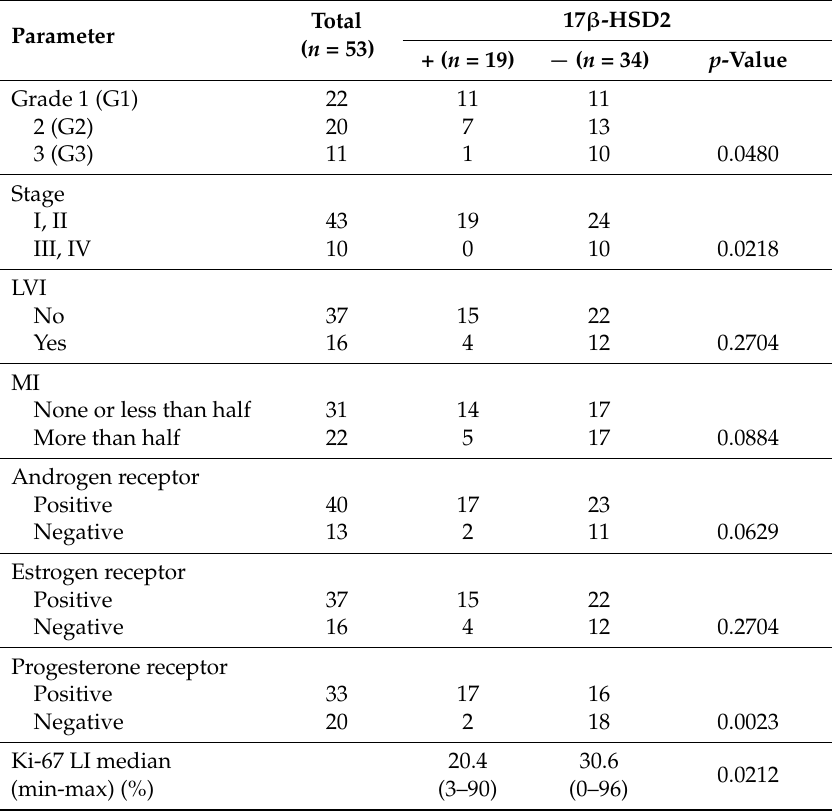
Table 1. Correlation between 17 β -HSD2 immunoreactivity and clinicopathological parameters in 53 patients with